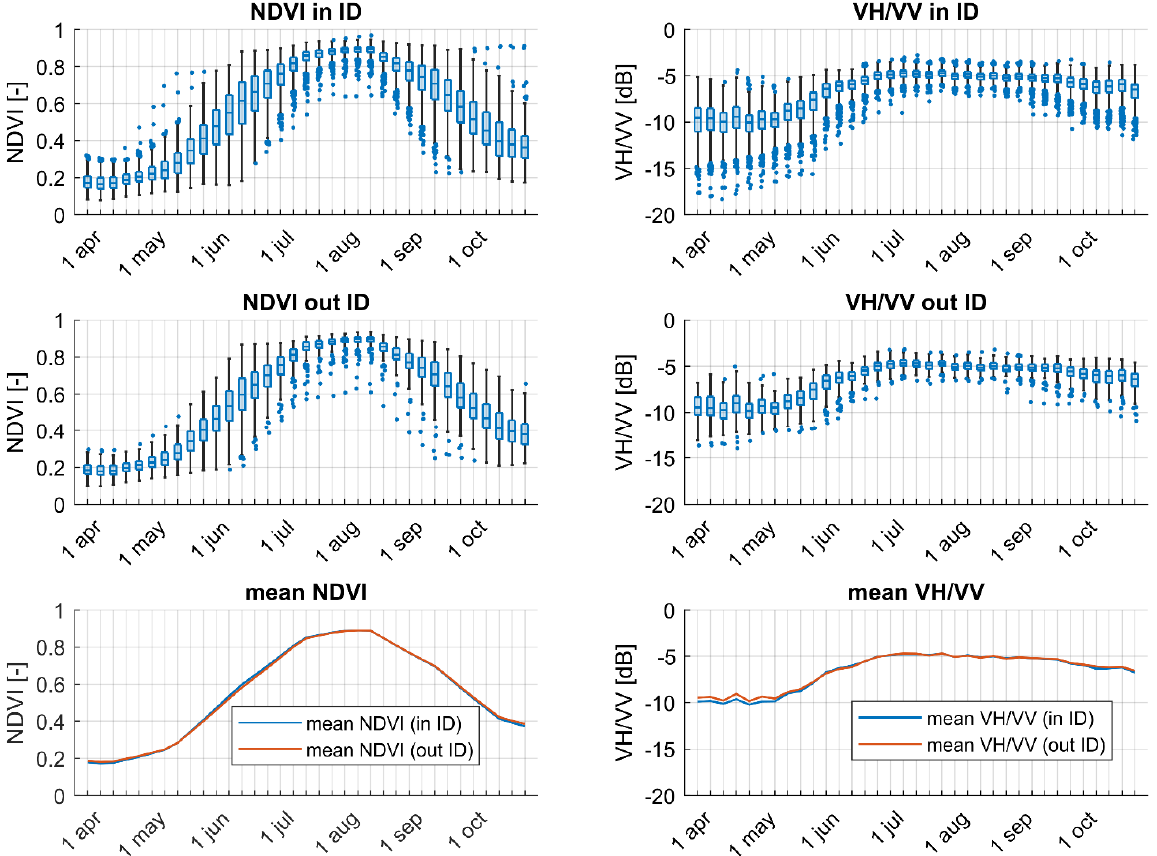
Figure 3. Time series of NDVI values (interpolation of 15–days revisit time) and VH/VV backscattering signal (6–days revised time). Each boxplot represents the distribution of values of NDVI and VH/VV from all the maize fields. The horizontal blue lines in the boxplots represent the 25%, 50%, and 75% quantiles, respectively (from the ground up). The black lines above and under each boxplot include the values within 95% and 5% quantiles, respectively. The blue dots represent the outlier values. In the two lowest subplots the mean daily values of the series are reported.